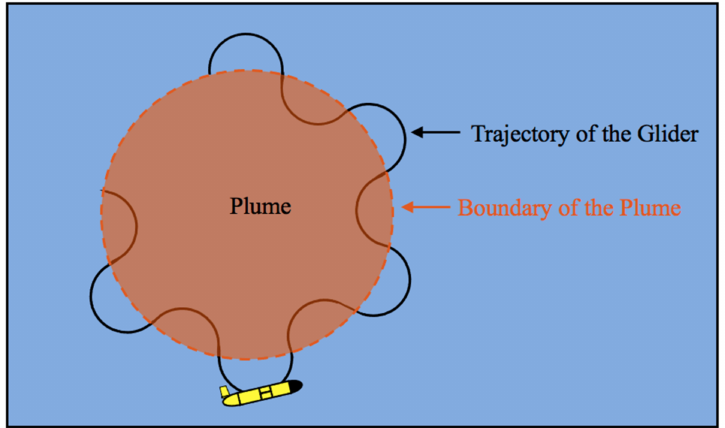
Figure 13. Adaptive changing of the heading of a glider to delineate the boundary of a plume based on the detection from